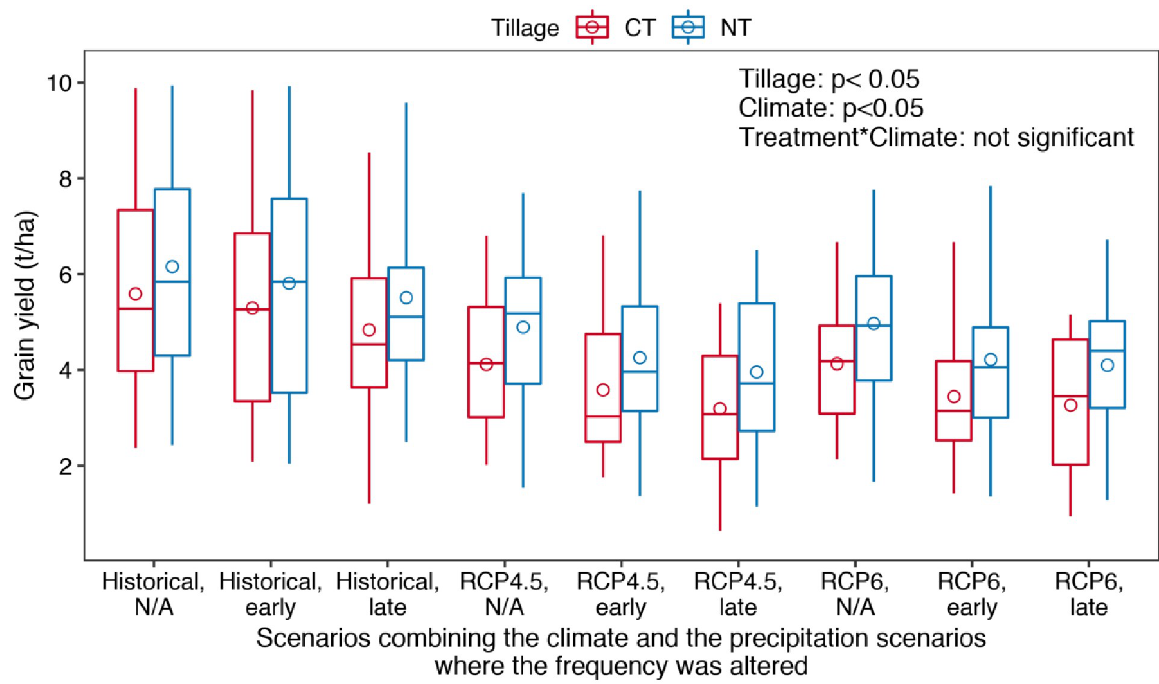
Fig 5. Distribution of the simulated maize grain yield under conventional (CT) and no-till (NT) treatments in the simulated 24 years under the nine climate treatments that combines three greenhouse gas concentration paths scenarios (historical, RCP4.5 and RCP6) and three precipitation frequency scenarios (no changes in precipitation frequency (N/A), and drought and heavy rainfall imposed for early or late growth stage) (p values are from the two-way ANOVA analysis; the top and the bottom of the box represent the first and the third quartile values, respectively; the line within the box presents the median value; the top and the bottom ends of the whiskers represent the maximum and the minimum values, respectively; the circle represents the mean value).